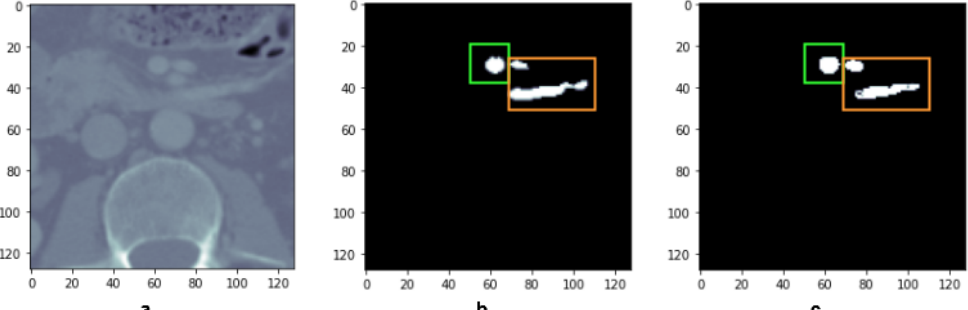
Figure 11. Portal vein sample 4: image ( a ), original mask ( b ) and predicted mask ( c ) after pre- processing with zoom.